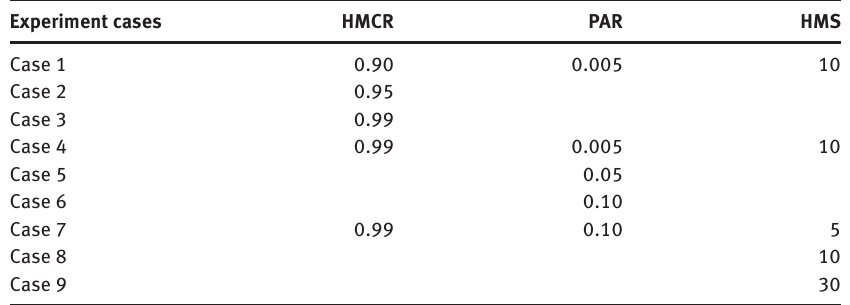
Table 3: The Nine Convergence Scenarios Designed to Evaluate the Sensitivity of HS Algorithm to its Parameters. Experiment